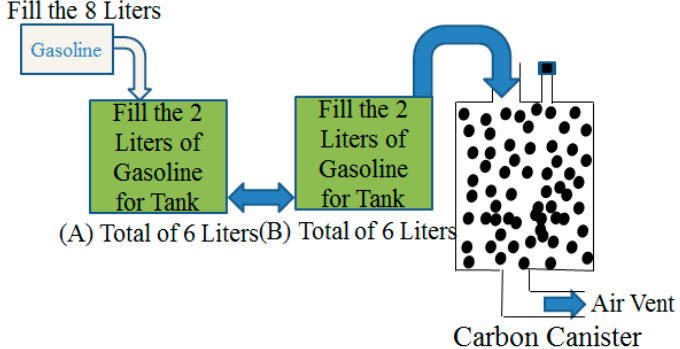
Figure 7. Schematic diagram of the test bench for the carbon canister adsorption test.